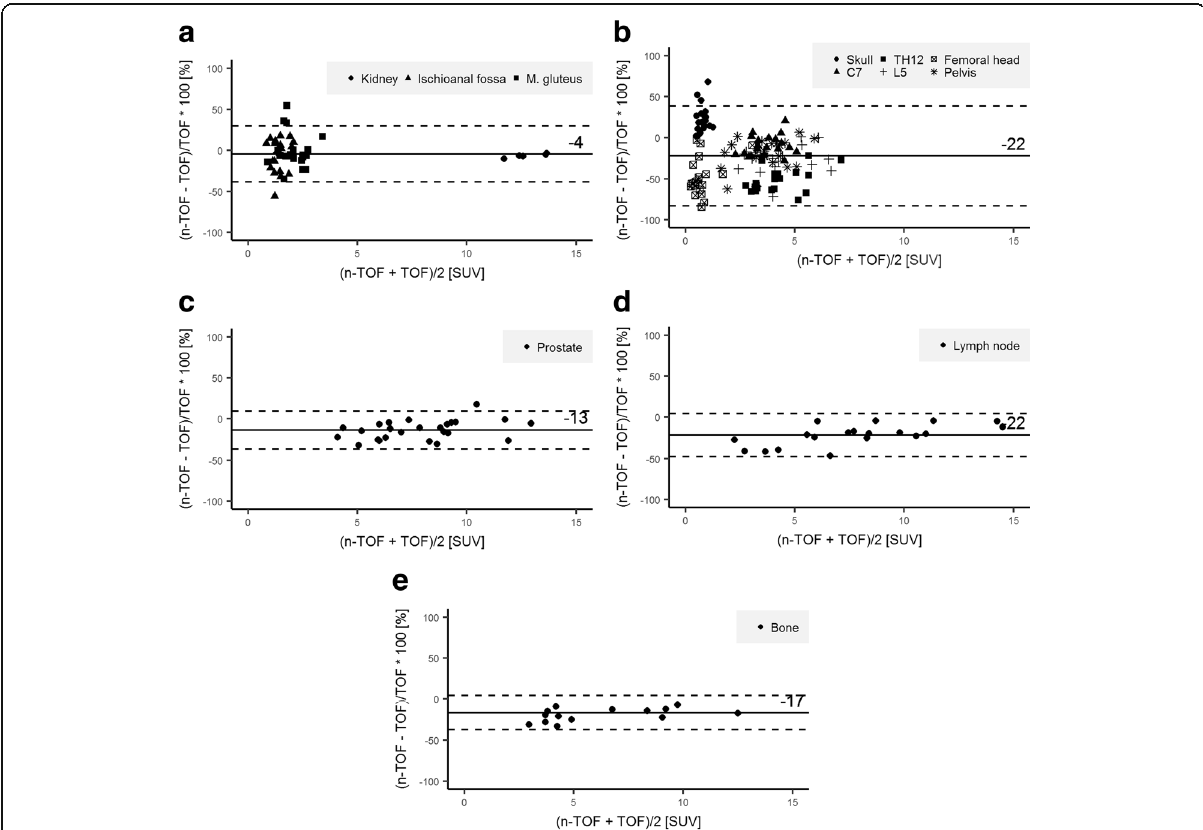
Fig. 1 Bland-Altman plots with mean (bold line) and twice the standard deviation (dotted lines) of relative difference of maximum standard uptake value in soft tissue ( a ), bone ( b ), prostate cancer ( c ), lymph node metastases ( d ), and bone metastases ( e ). Note the good correlation of TOF and non-TOF reconstructions in soft tissue and the high relative difference in bone and